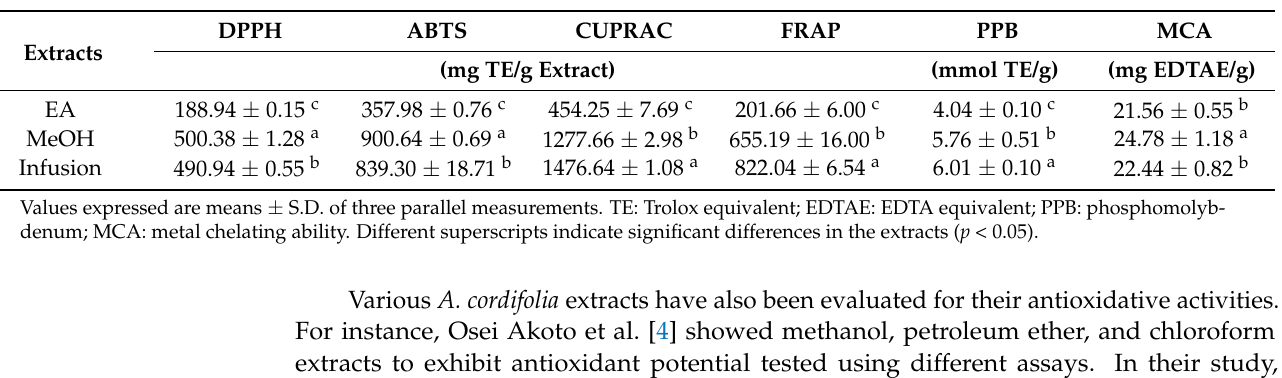
Table 3. Antioxidant activities of the tested